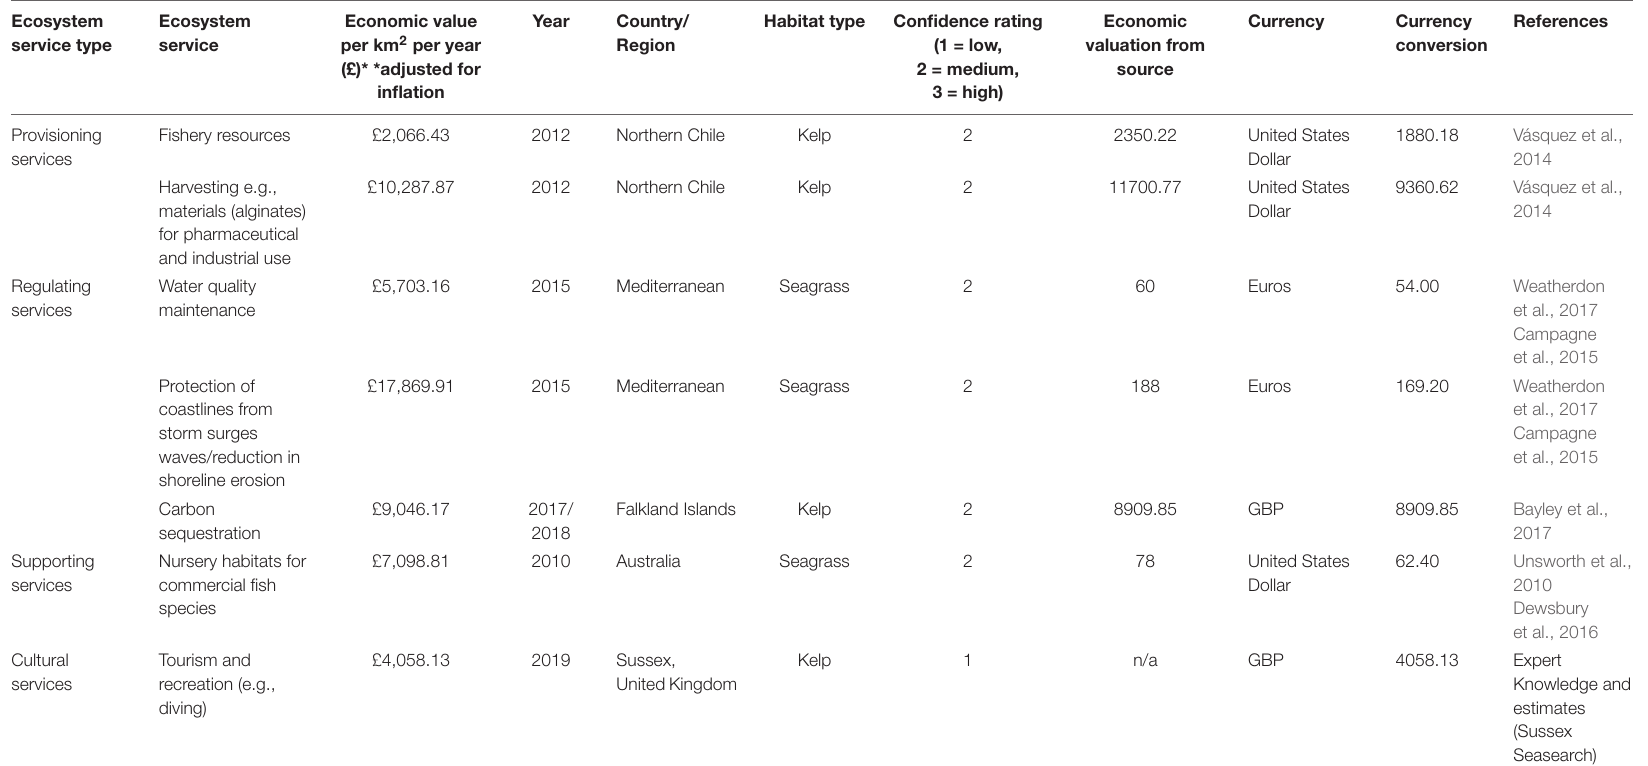
TABLE 4 | Kelp ecosystem service valuations used in